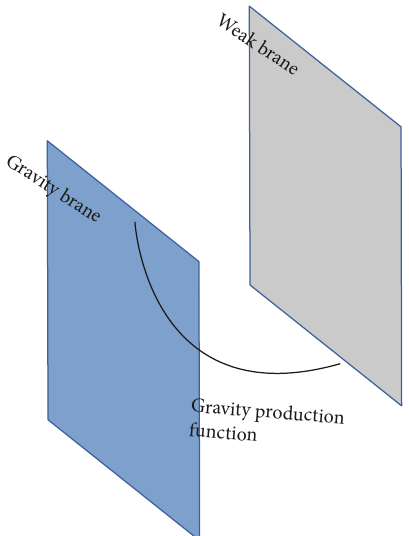
Figure 1: RS theory presented by the gravity and weak branes as the 4-dimensional boundaries of the extra dimension (from